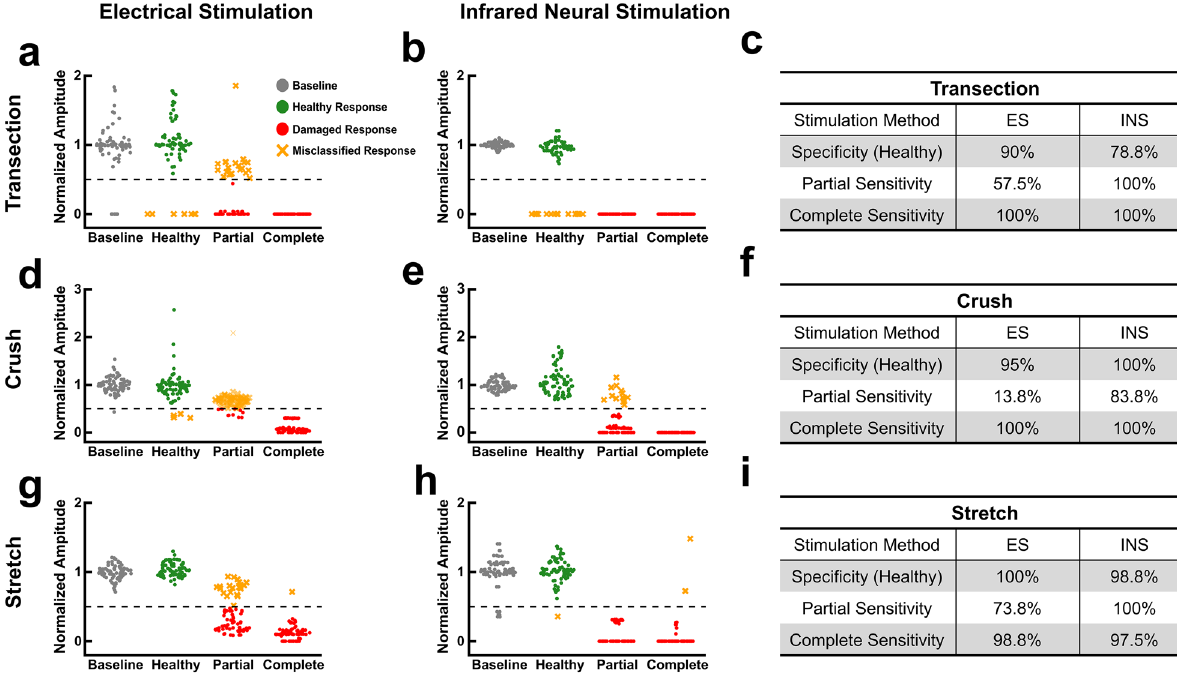
Figure 5. INS can be integrated in to existing clinical IONM systems while maintaining performance. ( a ) Normalized CMAP amplitudes resulting from ES in baseline, healthy, partial transection, and complete transection conditions. Black dashed line represents the amplitude damage threshold (50% decrease). ( b ) Normalized CMAP amplitudes resulting from INS in baseline, healthy, partial transection, and complete transection conditions. ( c ) Sensitivity and specificity for the amplitude-based IONM approach to transection injuries. ( d ) Normalized CMAP amplitudes resulting from ES in baseline, healthy, partial crush, and complete crush conditions. (e) Normalized CMAP amplitudes resulting from INS in baseline, healthy, partial crush, and complete crush conditions. ( f ) Sensitivity and specificity for the amplitude-based IONM approach to crush injuries. ( g ) Normalized CMAP amplitudes resulting from ES in baseline, healthy, partial stretch, and complete stretch conditions. ( h ) Normalized CMAP amplitudes resulting from INS in baseline, healthy, partial stretch, and complete stretch conditions. ( i ) Sensitivity and specificity for the amplitude-based IONM approach to stretch injuries. Specificity in all cases was calculated using the ‘Healthy’ category of responses. All data is normalized to the mean baseline values for each individual nerve. n = 4 nerves for all data sets (2